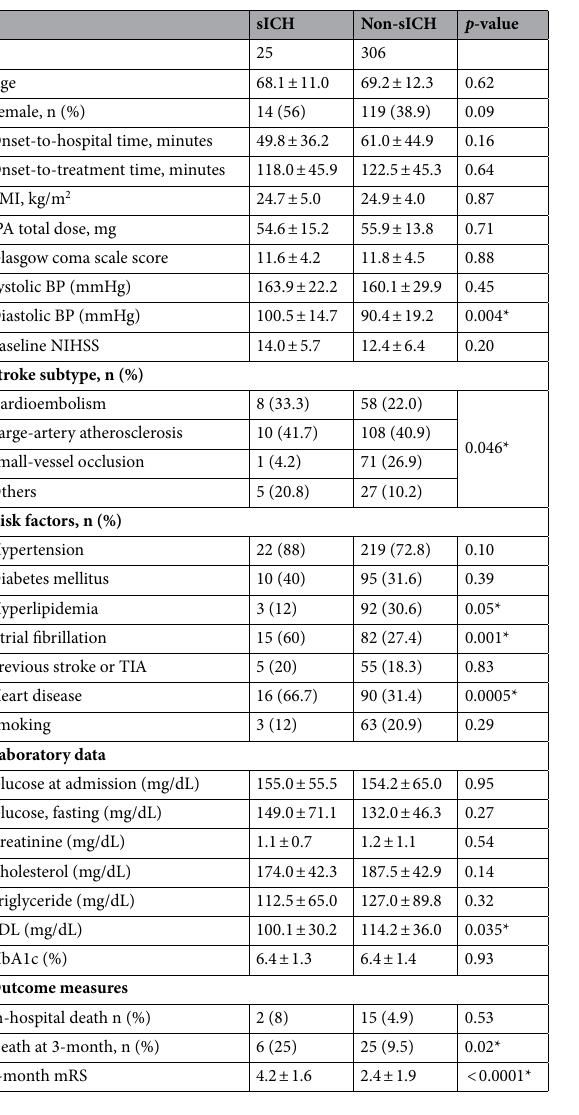
Table 1. Baseline characteristics of patients with and without symptomatic intracranial hemorrhage (sICH) after tPA. Continuous variables are presented as mean ± SD. One-way ANOVA was used for continuous variables, and Fisher’s exact test was used for categorical variables. BMI, body mass index. BP, blood pressure. HbA1c, hemoglobin A1c. sICH, symptomatic intracranial hemorrhage. LDL, low-density lipoprotein. NIHSS, National Institutes of Health Stroke Scale. mRS, modified Rankin Scale. TIA, transient ischemic attack. tPA, tissue plasminogen activator. * p- value <